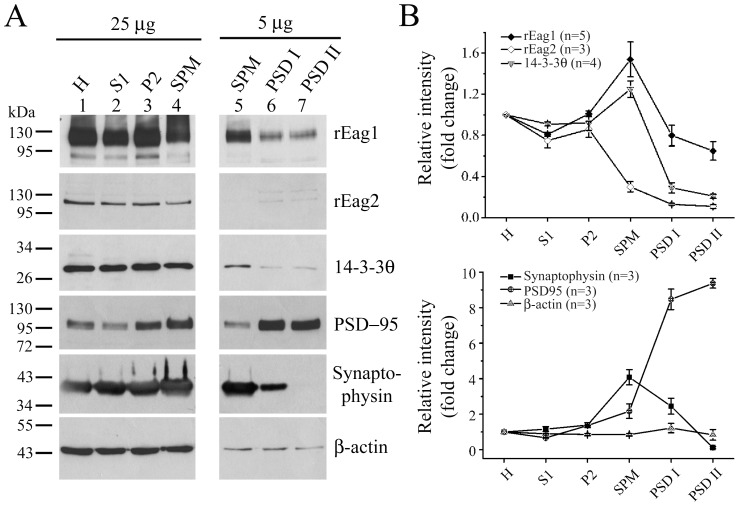
Localization of 14-3-3θ and rEag1 in synaptosomal and PSD fractions.
(
A
) Subcellular fractionation separated rat brains into multiple fractions: homogenate (H), soluble fraction (S1), crude membrane fraction (P2), synaptosomal fraction (SPM), and two postsynaptic density (PSD) preparations (PSD I: one Triton X-100 wash; PSD II: two Triton X-100 washes), all of which were subject to immunoblotting analyses with the indicated antibodies. 25 µg and 5 µg refer to the amount of total protein loaded in each lane. (
B
) Quantitative analyses of protein abundance in different subcellular fractions. Densitometric scans of immunoblots were obtained from three to five independent experiments. Data were presented as normalized values with respect to cognate protein expression levels in the homogenate (H) fraction.